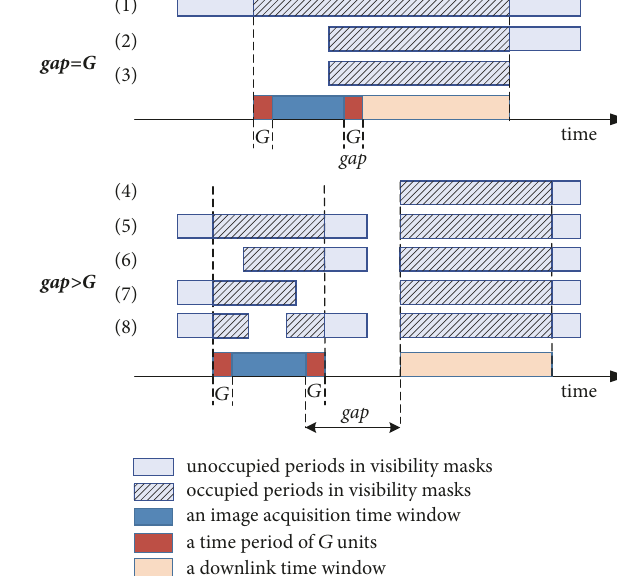
Figure 2: The case that using the delay rule leads to missing the optimal schedule.